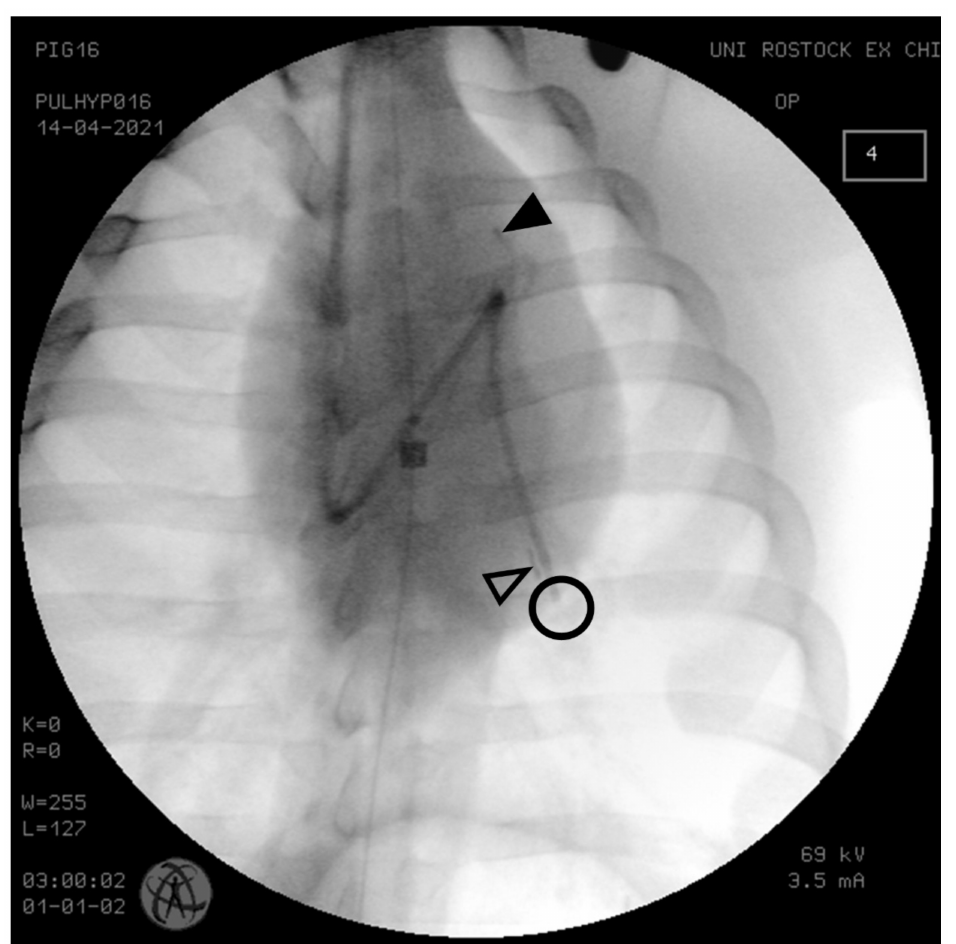
Figure 2. X-ray of the thorax to assess correct positions of catheters. A conventional pulmonary artery (Swan-Ganz) catheter was placed in the pulmonary artery for gold standard measurement of pulmonary artery pressure (circle). The sensors of two Millar Mikro-Tip catheters are located in a proximal (filled triangles) and a distal branch of the (open triangles) pulmonary artery (, X-ray taken with the C-Arm Ziehm Vision, Ziehm Imaging, Nuremberg,